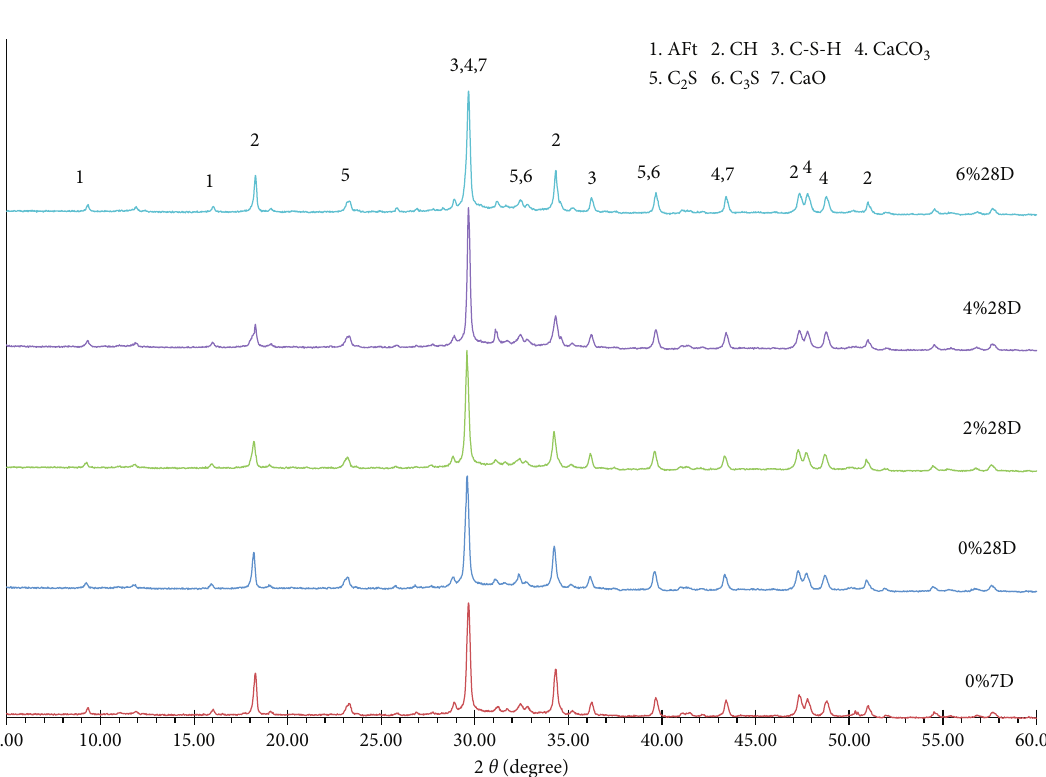
Figure 6: XRD patterns of the samples after being cured for 7 days and 28